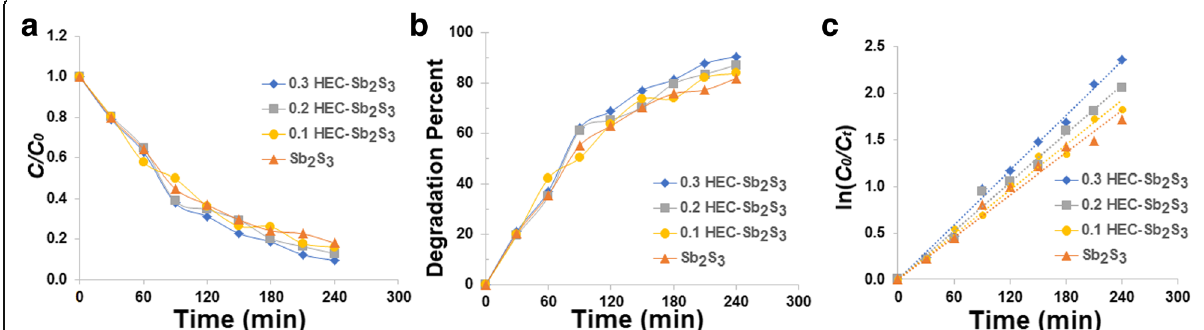
Fig. 10 a – c The adsorption kinetic, photocatalytic degradation, and first-order plot of MB solution by Sb 2 S 3 , 0.1 HEC-Sb 2 S 3 , 0.2 HEC-Sb 2 S 3 , and 0.3 HEC-Sb 2 S3 photocatalysts